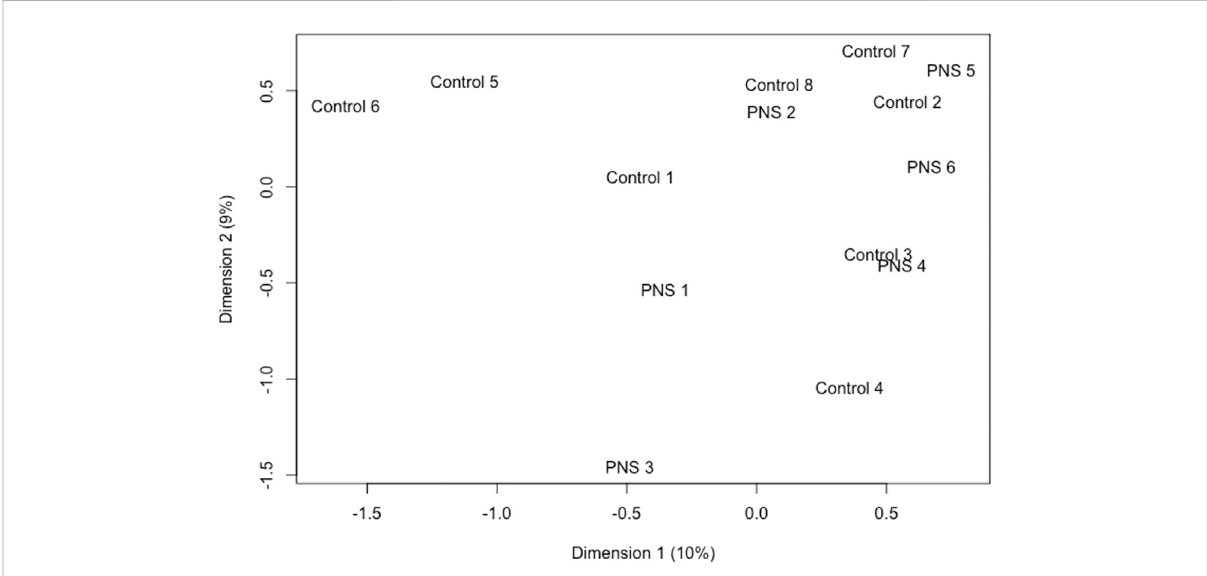
FIGURE 2 Multidimensional scaling plot utilizing the base 2 logit transformation of the proportion of methylated signal at each locus to plot distances between methylation pro fi les (M-Values) of amygdala tissue of 5-year-old prenatally stressed (PNS) Brahman cows relative to control